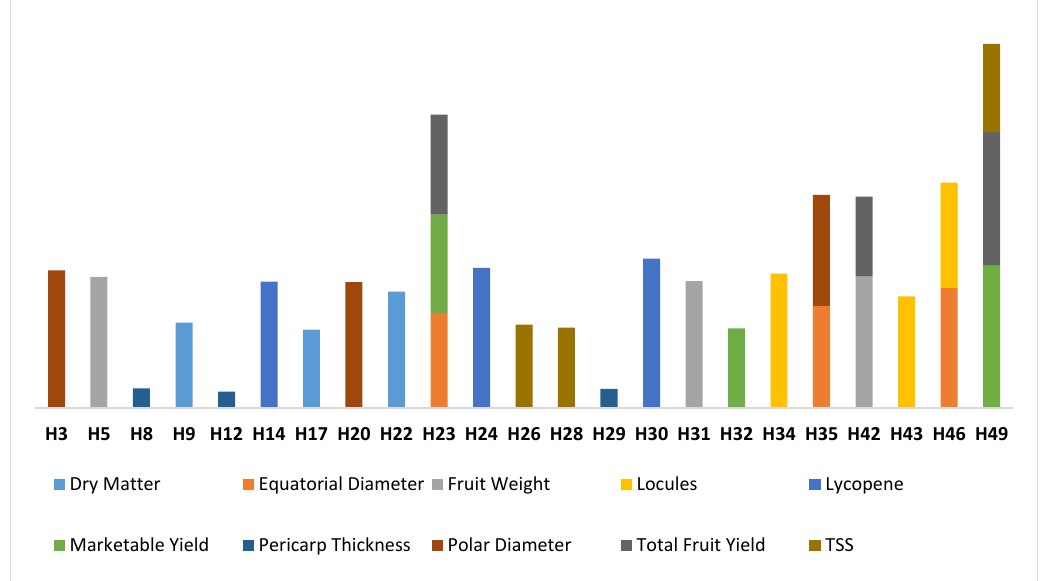
Figure 6. Promising hybrid cross combinations identified based on SCA values, under leaf curl virus infestation.